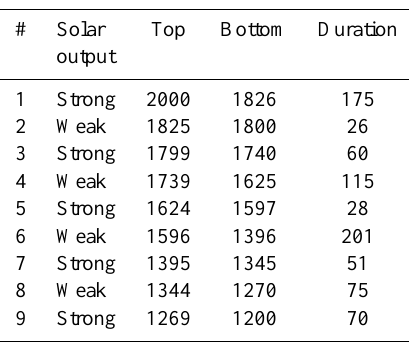
Table 1. The periods of stronger and weaker solar output over the past